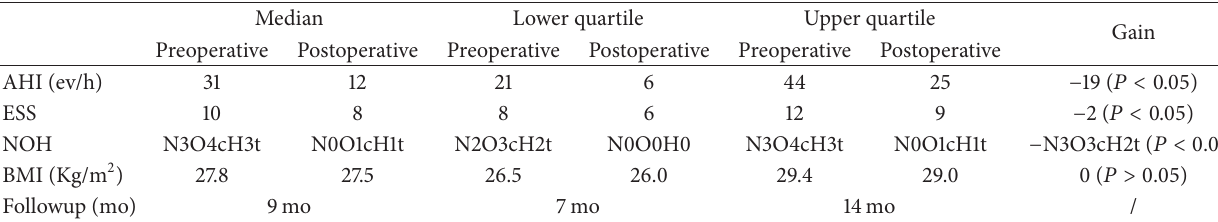
Table 1: Pre-/postoperative statistical data.